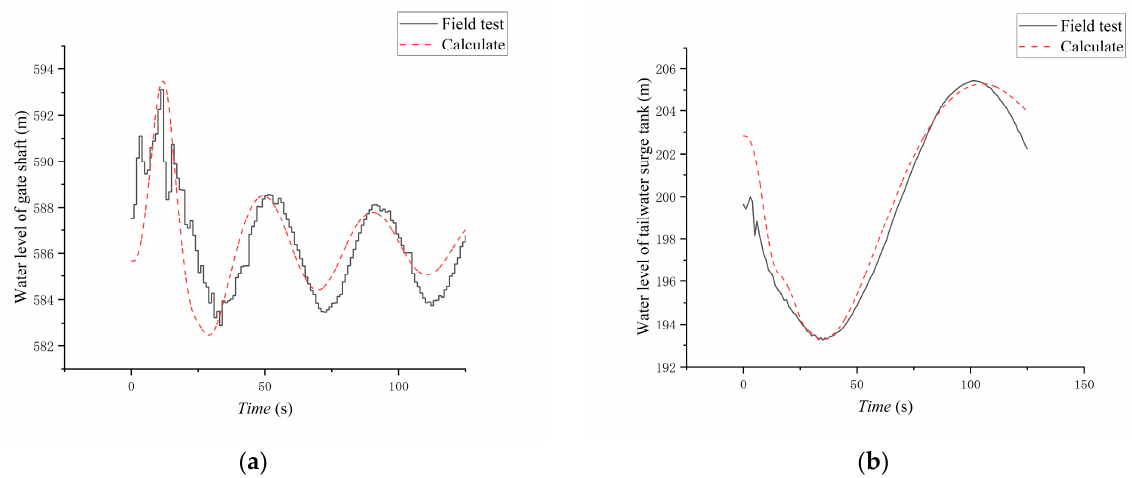
Figure 4. Water level simulation and field test: ( a ) gate shaft, ( b ) tailwater surge tank.